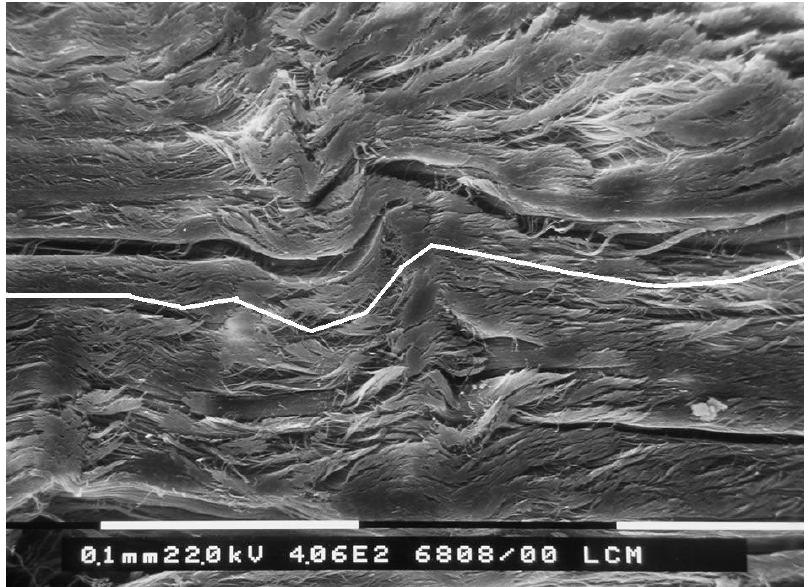
FIGURE 2. Rat medial collateral ligament incubated in ChABC observed at SEM. Densely packed collagen fibers mainly running almost straight and parallel show occasional undulations or crimps of different sizes. A cross-connection of collagen fibers can also be seen (indicated by the white line). Bar = 100